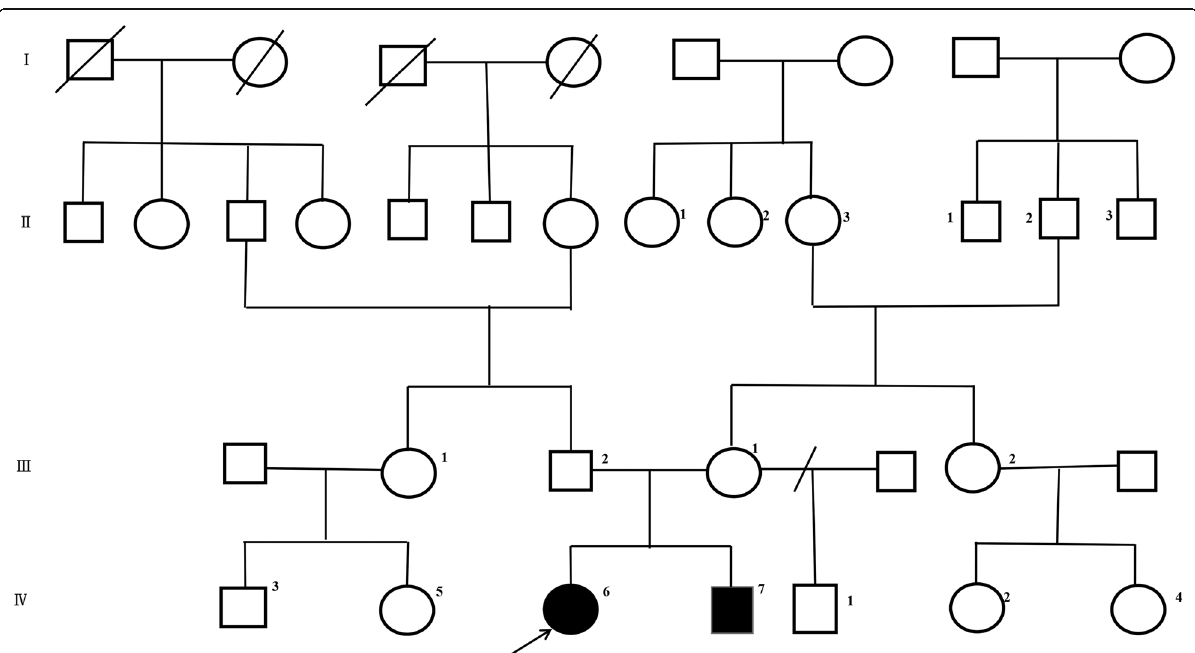
Fig. 1 Pedigree of family 1 with CDG. Unaffected subjects are denoted as blank while affected subjects are represented with darkened symbols. The arrow indicates the